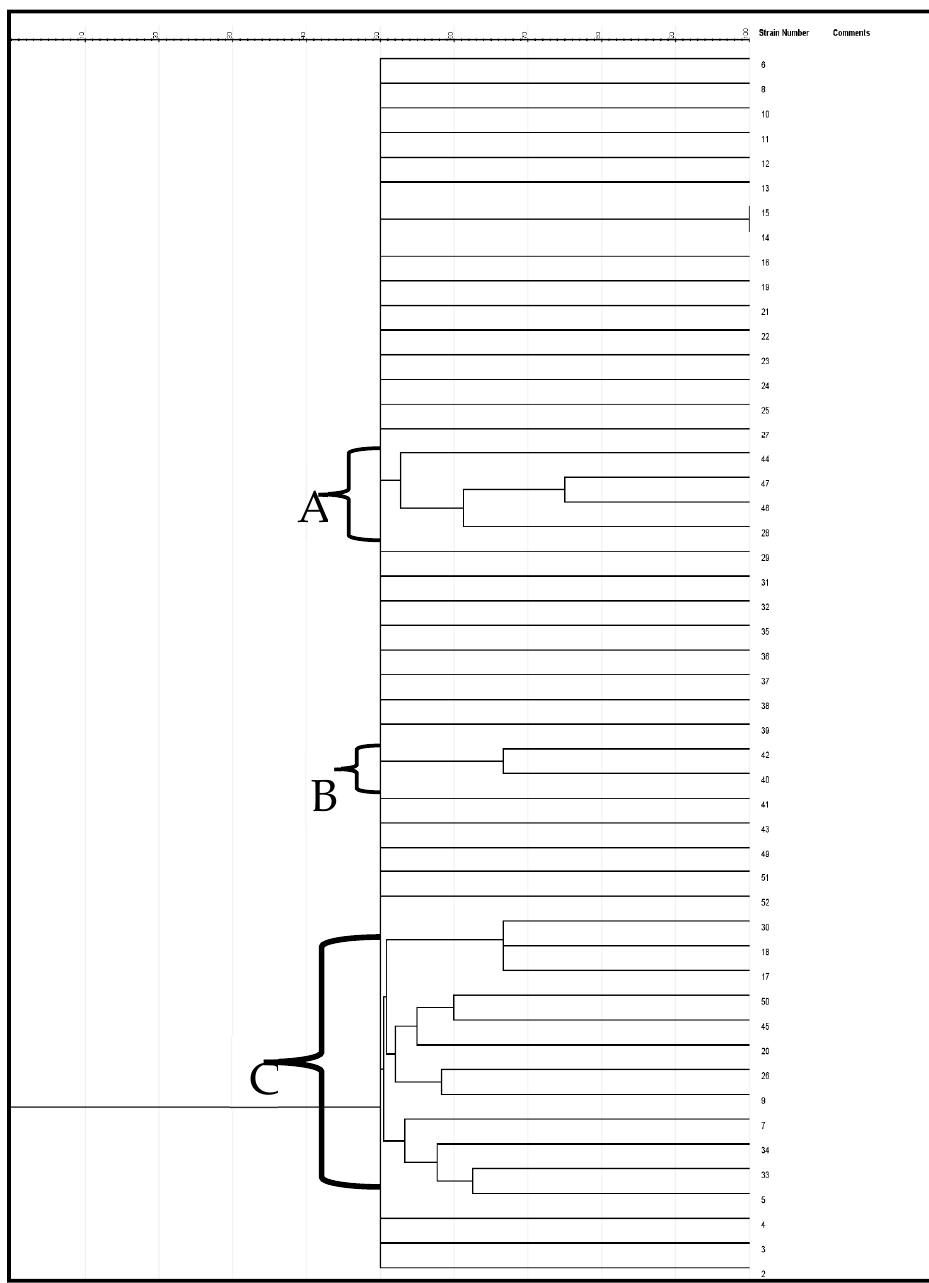
Figure 5. A neighbor-joining dendrogram of ERIC-PCR fingerprints of Enterococcus strains.